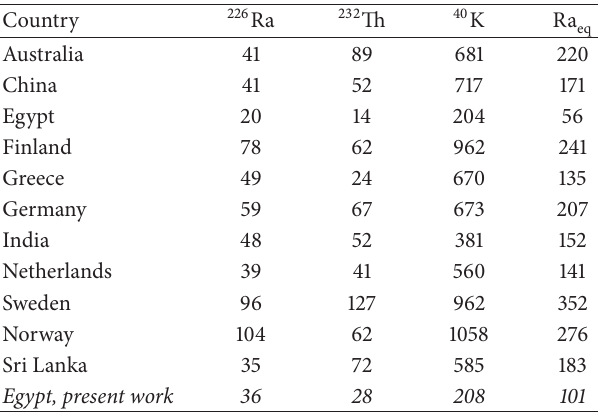
Table 4: Comparison of 226 Ra, 228 Ra, and 40 K and radiation hazard parameter in clay from around the world